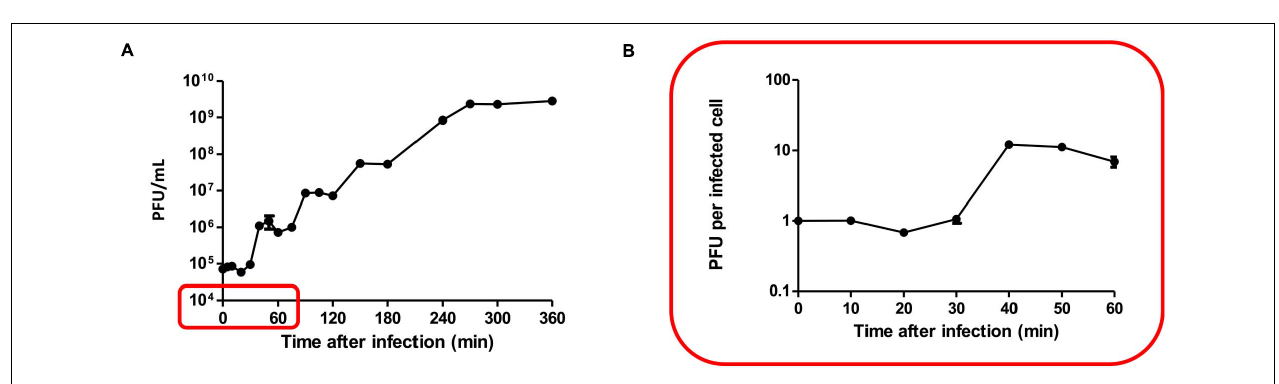
FIGURE 3 | WTA-dependent infection of S. aureus phage PALS2. Phage PALS2 lysate was spotted onto lawns of (A) wild-type RN4220, (B) (cid:49) tagO :erm mutant, T174, and (C) tagO -complemented strain, T111. The numbers in the table indicate the titer (PFUs/mL) of phage PALS2 spotted on the plate. Plaque formation indicates successful adsorption and infection by phage PALS2.